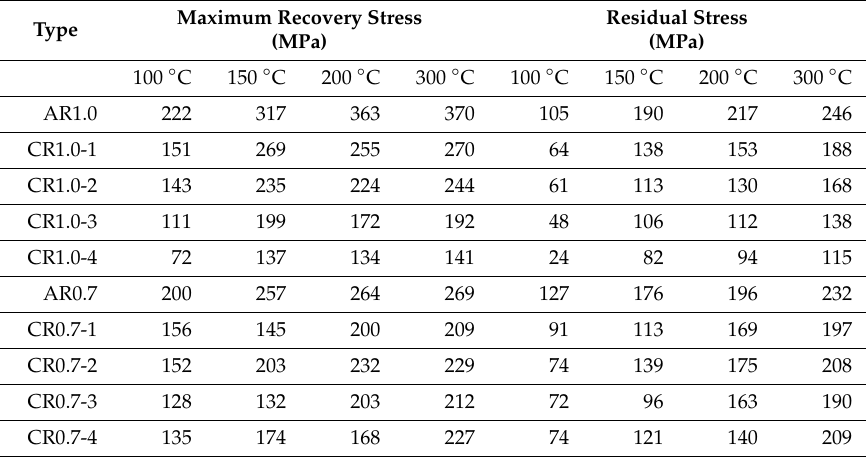
Table 4. Maximum recovery stress and residual stress of AR and CR fibers.